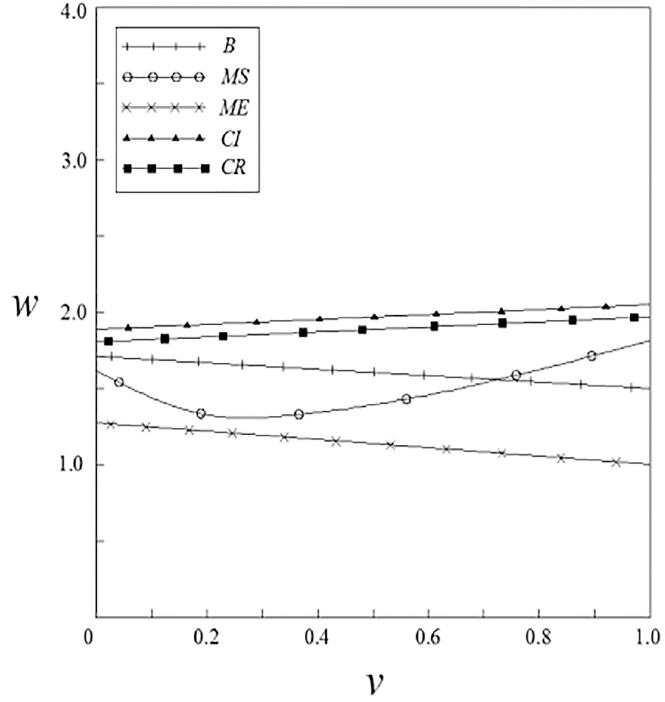
Fig 7. The relationship between w and ν .